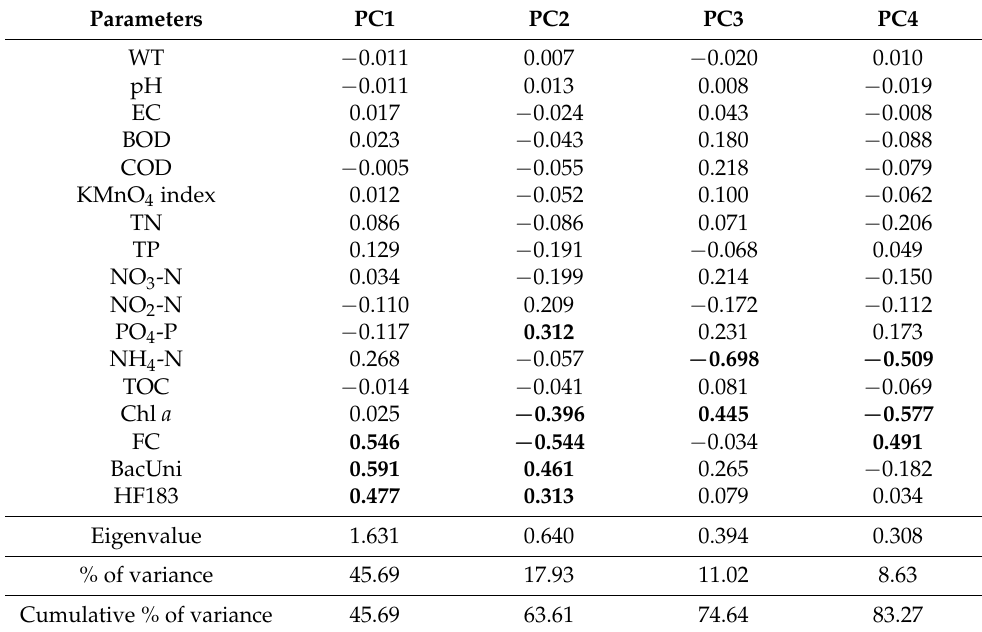
Table 1. Loadings of physicochemical and microbiological variables resulting from PCA analysis. The four principal components (PC1 to PC4) are shown, and the values in bold indicate moderate or weak